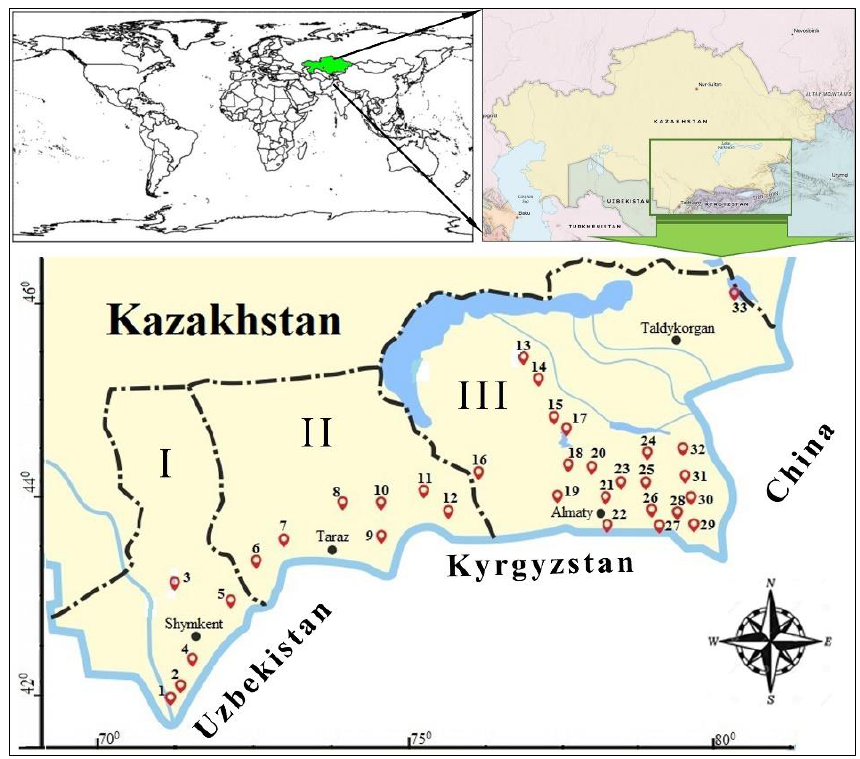
Figure 1. Location of investigated sites in south and southeast Kazakhstan, 2019 – 2022. Table 1. Locations of study sites in south and southeast Kazakhstan, 2019 – 2022. Asterisk indicates sites sampled for the first time.